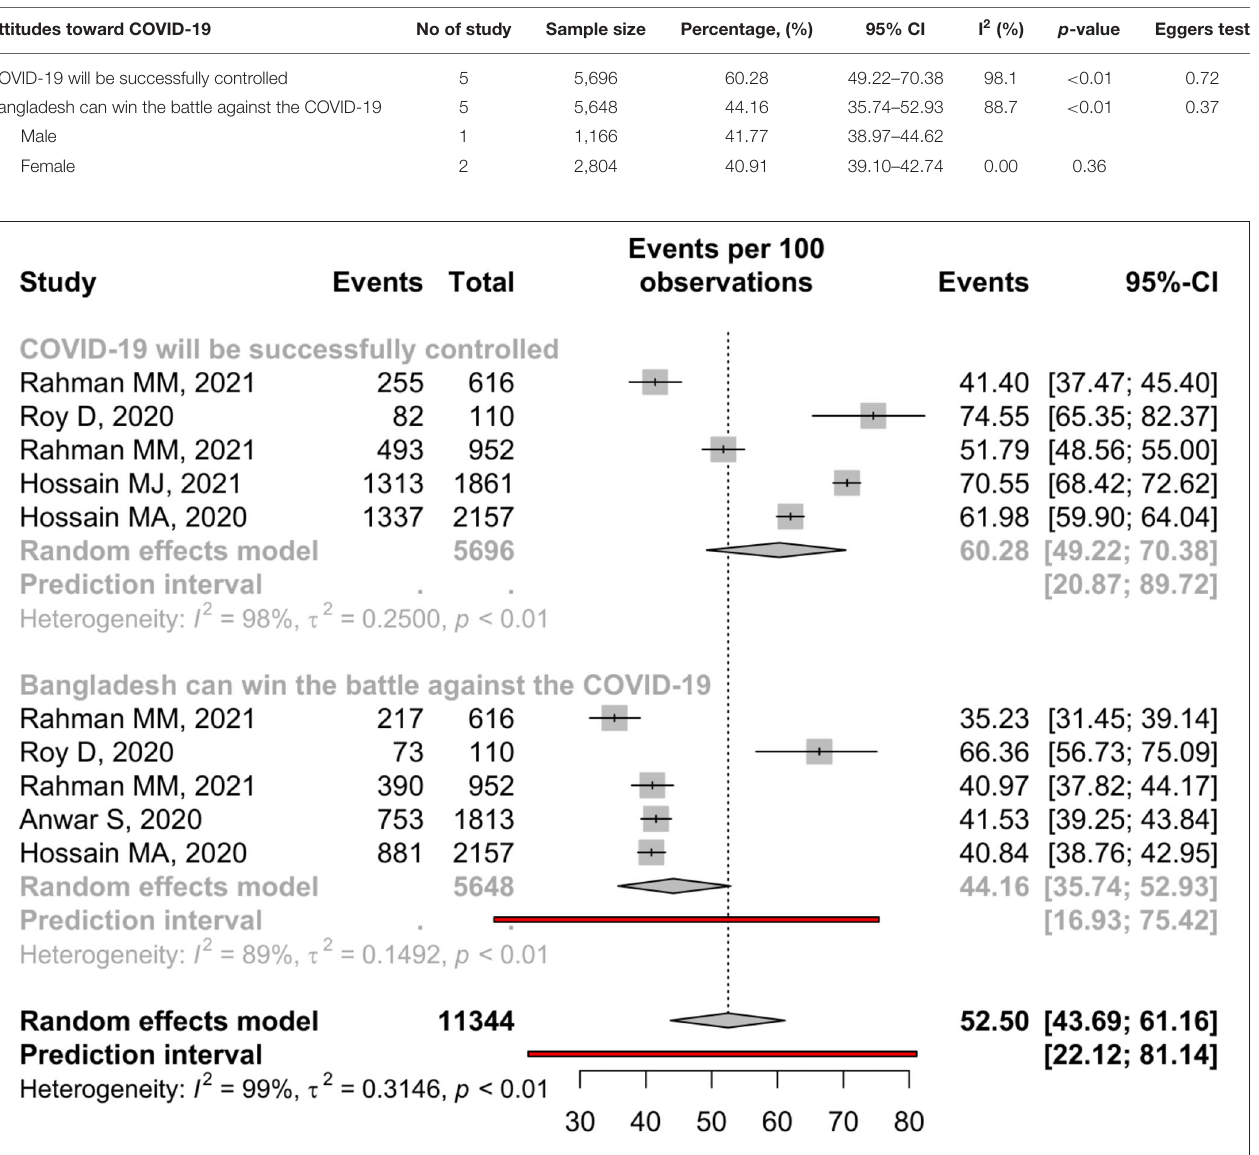
FIGURE 5 | Attitude toward COVID-19 among Bangladeshi residents.